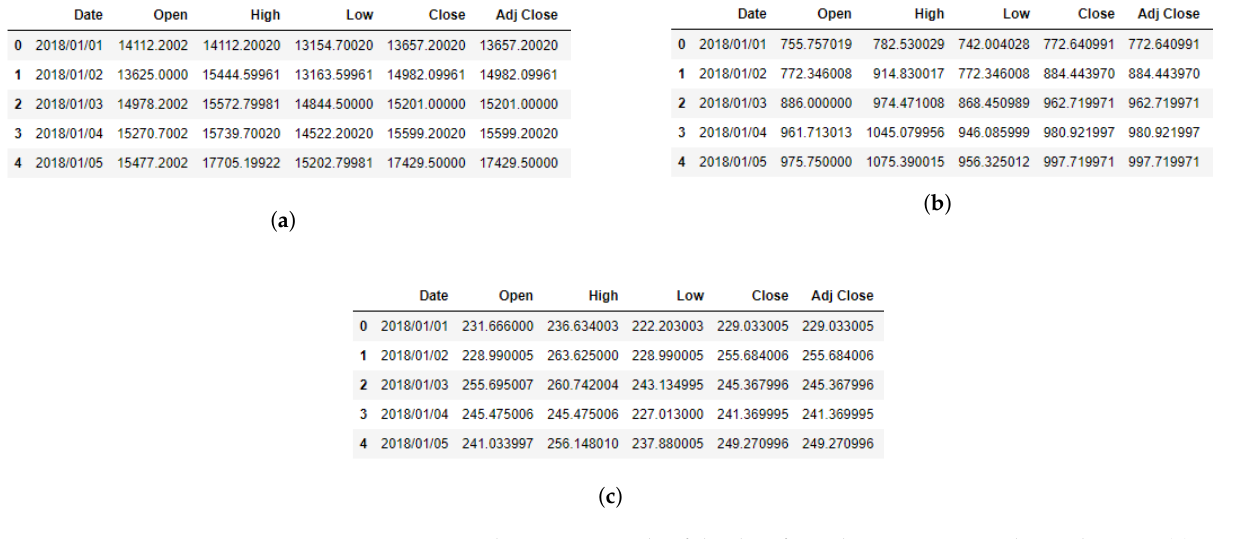
Figure 6. A snippet showing a sample of the data from the BTC, ETH, and LTC datasets. ( a ) sample of the BTC dataset; ( b ) sample of the ETH dataset; ( c ) sample of the LTC dataset. The correlation matrix Figure 7 below demonstrates the Pearson correlation coefficient between the targeted cryptocurrencies. In Pearson correlation, we say that variables are correlated when a change in the value of one affects the other. Variables are said to be significantly correlated when the coefficient r is greater than 0.5, and the coefficient lies between [–1, 1]. The correlation matrix indicates a positive correlation between the closing prices for BTC, LTC, and ETH. This implies that, if one of the coin prices rises or falls, the others will follow suit.